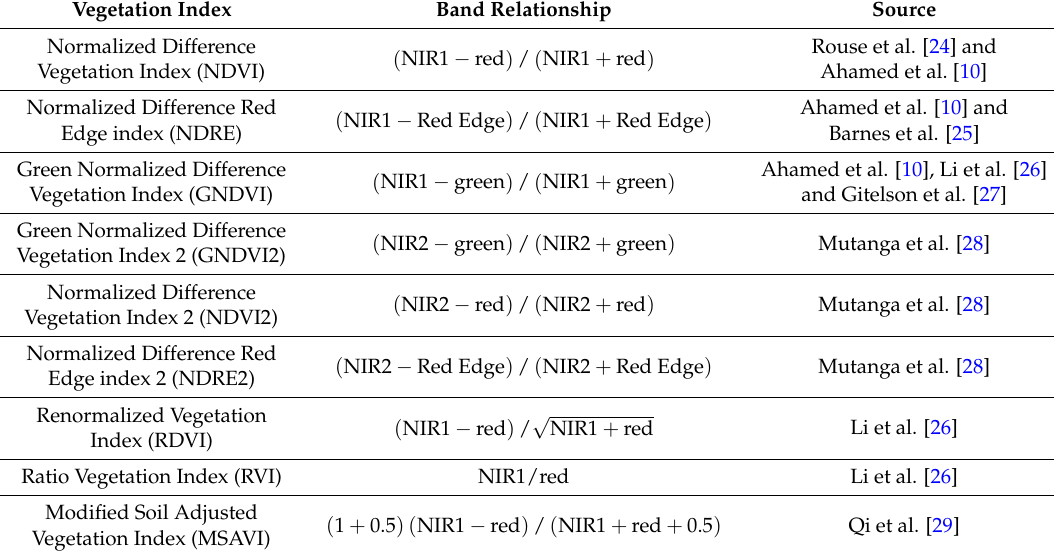
Table 2 were calculated for predicting AGB and LAI from WV2 data. Then, spectral bands of the WV2 satellite image and vegetation indices were stacked together to form one image with multiple layers (15 layers) for further processing. Table 2. Predictor variables generated from the WorldView-2 multispectral image for estimating above ground biomass and leaf area index. NIR1, NIR2, red edge, red and green: surface reflectance of Near Infrared 1, Near Infrared 2, red-edge, red and green wavelength regions,